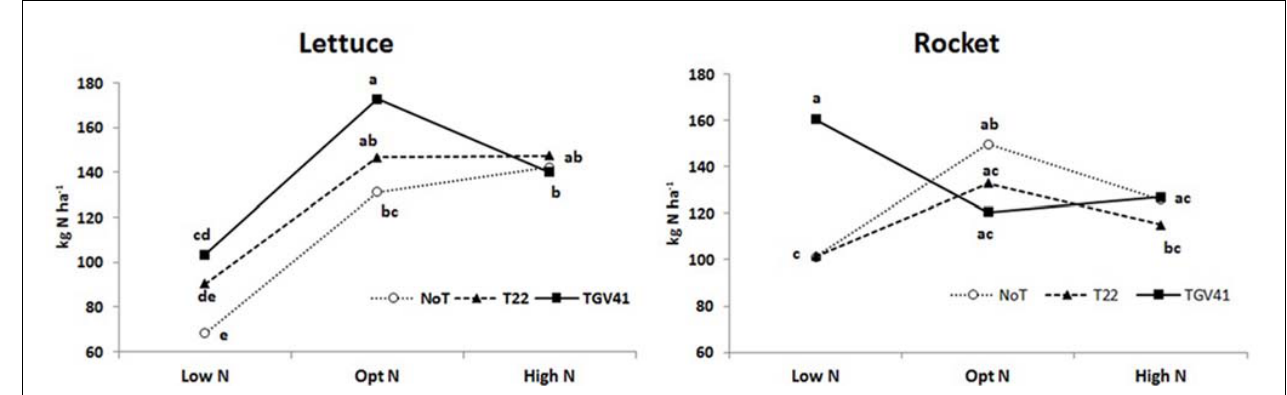
FIGURE 3 | Total N uptake for lettuce and rocket as affected by different N doses and Trichoderma inoculation. Low N, non-fertilized conditions (low N availability) for both crops; Opt N, optimal N fertilization, amounting to 90 kg N ha − 1 and 60 kg N ha − 1 for lettuce and rocket, respectively; High N, supraoptimal N fertilization, amounting to 180 and 120 kg N ha − 1 for lettuce and rocket, respectively; NoT, non-inoculated control; T22, T. harzianum strain T22; GV41, T. virens strain GV41. Different letters indicate different means according to LSD test ( P < 0.05).